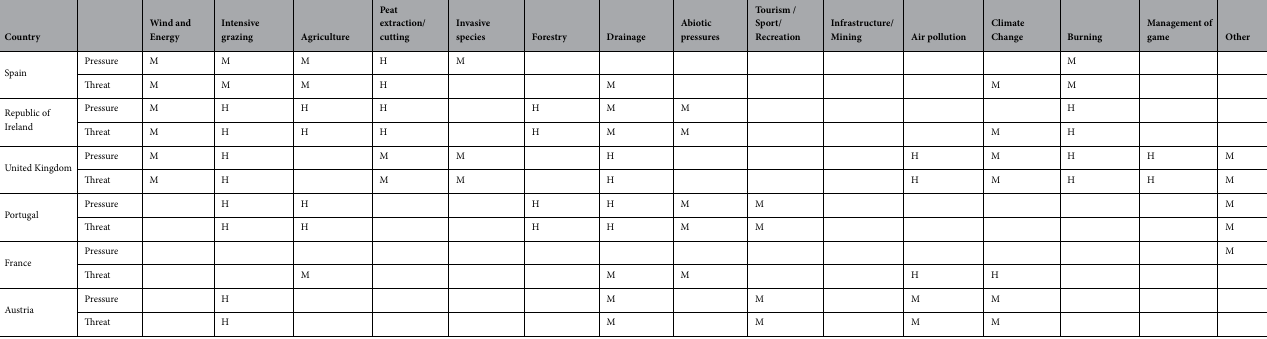
Table 1. Pressures and threats on recognised blanket bogs across the EU and UK according to the last habitat assessments 19 . Sweden has not reported this information in their last habitat assessment. H = High, M =